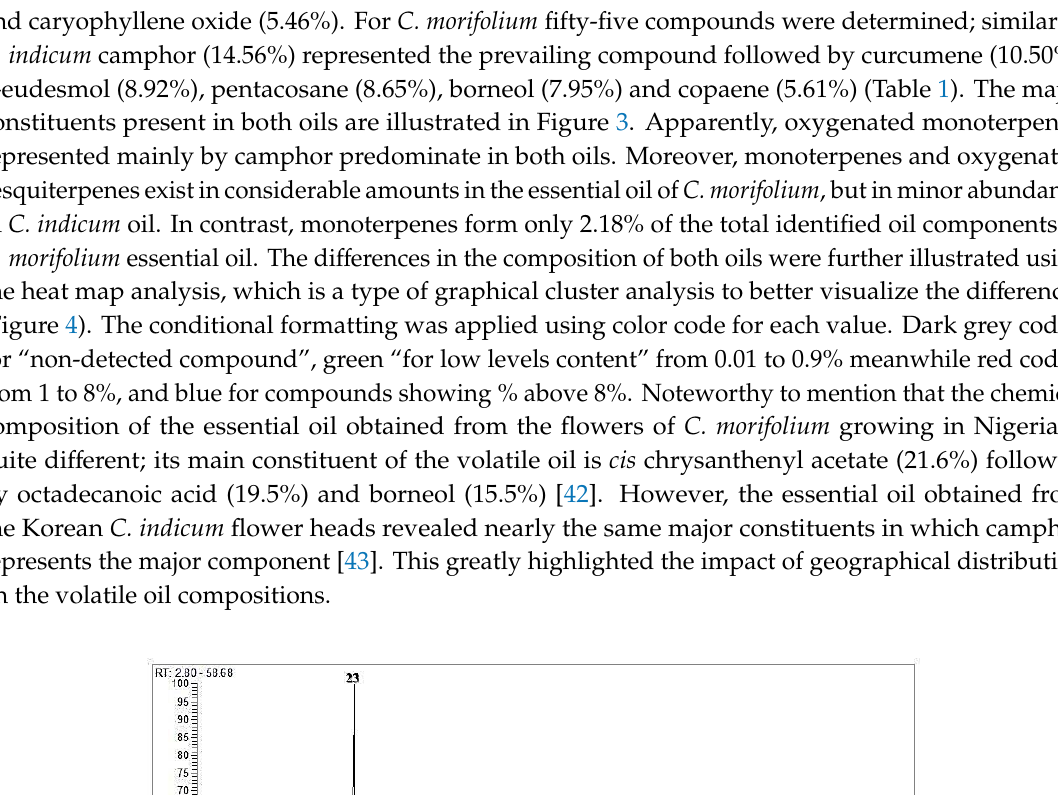
Figure 3. Major constituents of C. indicum and C. morifolium essential oils.